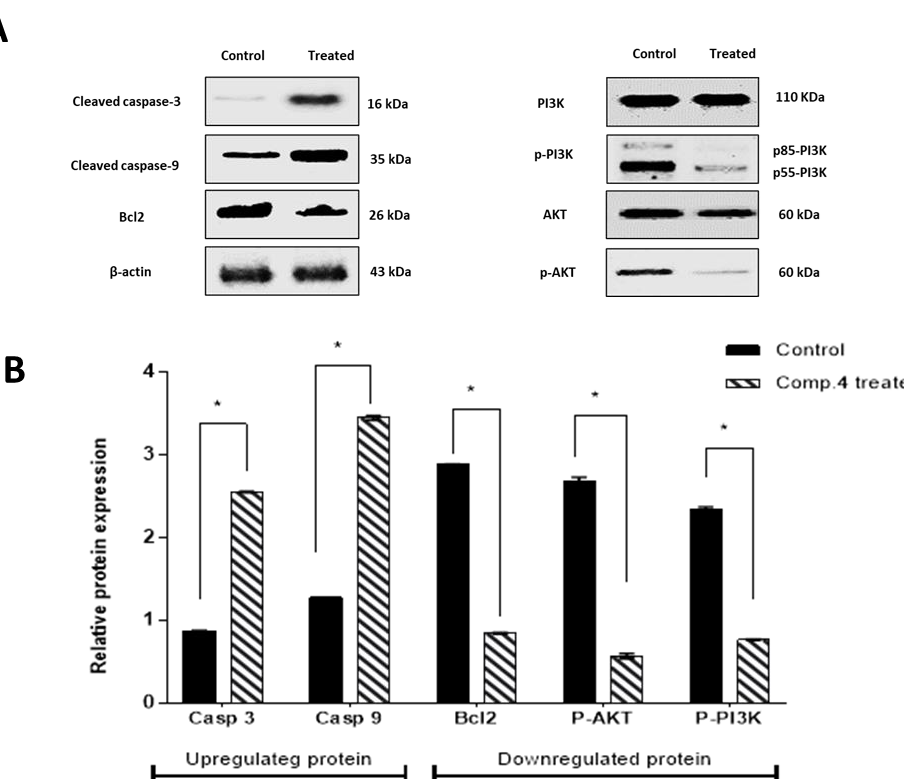
Figure 6. Effects of compound 4 on the expression of apoptosis-related proteins. Band widths ( A ) and quantification ( B ). The protein expression of Caspase 3 and 9, Bcl-2, PI3K, and AKT in HepG2-treated cells and control. Data were normalized using β -actin. Values are represented by mean ± SE ( n = 3 independent sample per group). * Significant difference between control and treated groups using an unpaired Student’s t-test ( p ≤ 0.05) using SPSS Ve rsion 22.